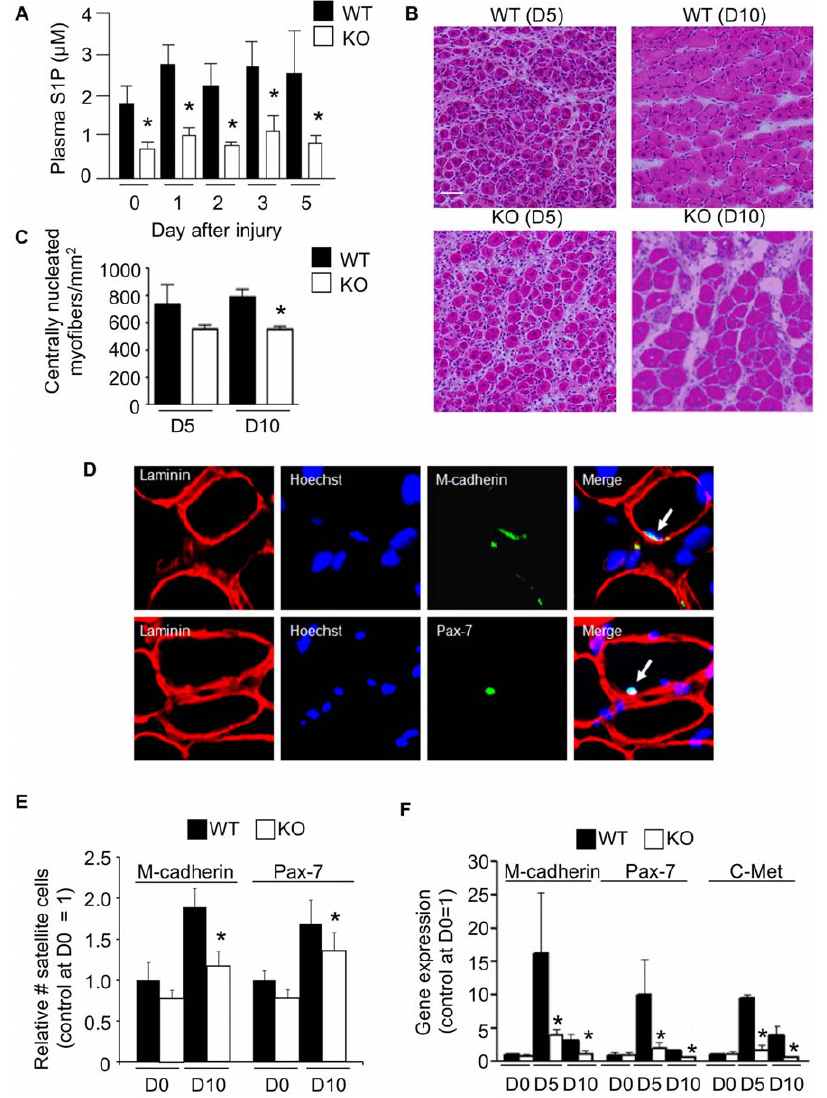
Figure 2. SphK1 disruption and S1P deficiency impairs muscle regeneration and SC recruitment. NTX injury was performed in WT C57BL/6 mice and SphK1 KO mice in the C57BL/6 background. Blood plasma and gastrocnemius muscles were harvested at different time points after injury. A) Plasma levels of WT and KO mice. B) Representative H&E stained frozen muscle sections of WT and SphK1 KO mouse muscles at the point of maximal injury. Scale bar=50 microns. C) Fiber counts at days 5 and 10. D) Representative immunofluorescence staining on injured C57 BL/6 muscle sections with Hoechst (blue) for nucleus, laminin (red) for basal lamina and Pax-7 (green) or M-cadherin (green) for SCs. Arrow shows merged signals. E) Quantitation of SCs, identified by sublaminar mononucleated cells expressing Pax-7 or M-cadherin in WT and SphK1 KO muscles at baseline (day 0) and 10 days after injury. * p # 0.05 (KO at day 10 compared to WT at day 10 for both markers). F) Gene expression of SC markers (Pax-7, M-cadherin and c-Met) in uninjured (D0) and injured muscles at 5 and 10 days post injury. Data are expressed as means 6 SD; n=4 for immunostained cryosections; n=3 for Western blot analysis; n=3–5 for qRT-PCR; * indicates a significant difference between WT and KO at that time point, p # 0.05. doi:10.1371/journal.pone.0037218.g002 fluorescent antibodies against the SC markers Pax-7 or M- cadherin, along with laminin to identify basal lamina and Hoechst staining of nuclei. SCs were identified as Pax-7 or M-cadherin positive, sub-laminar, mono-nucleated cells found in association with myofibers. A representative SC is shown in Figure 2D.